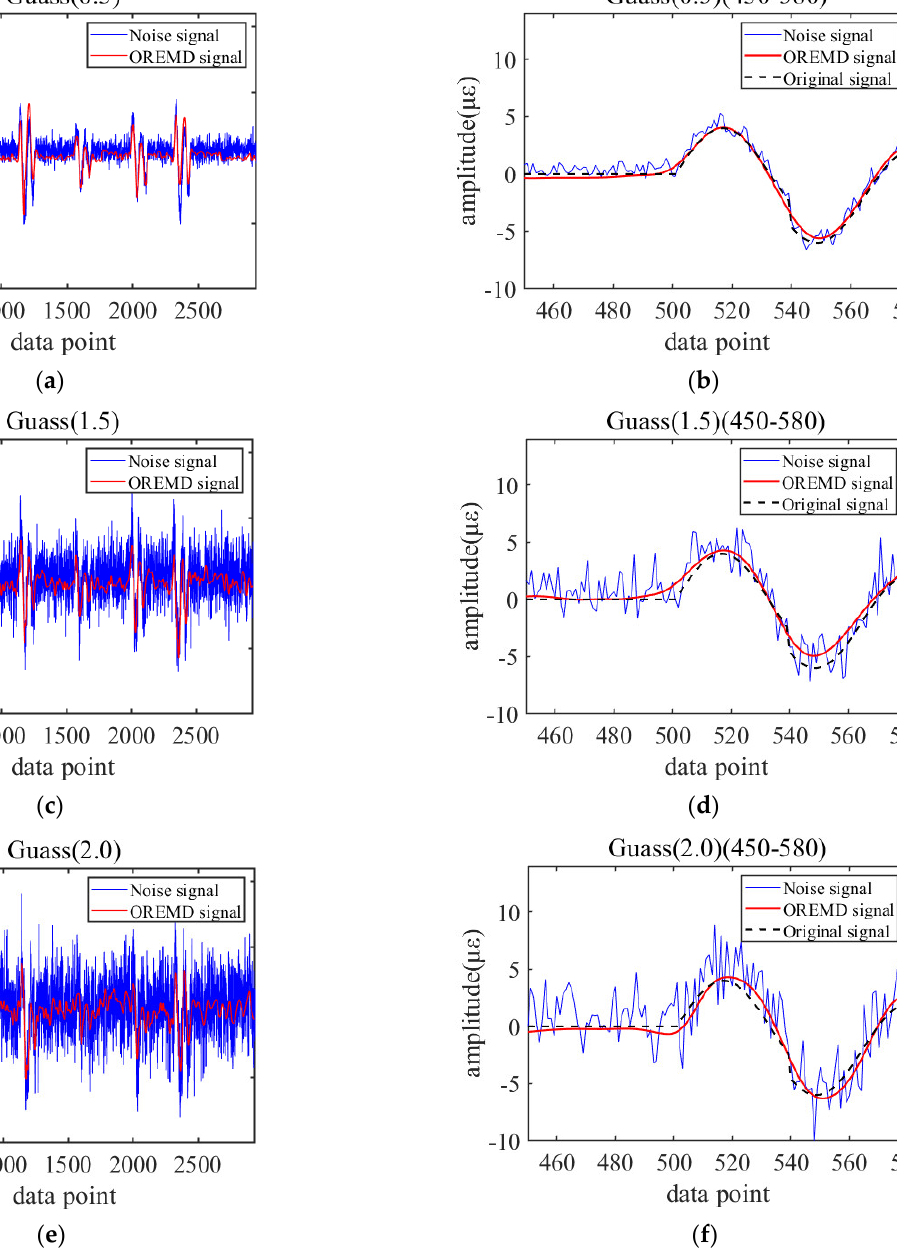
Figure 9. Gaussian noise original signal with different variance and sifted signal: ( a , b ) 0.5 standard deviation, ( c , d ) 1.0 standard deviation, ( e , f ) 2.0 standard deviation.